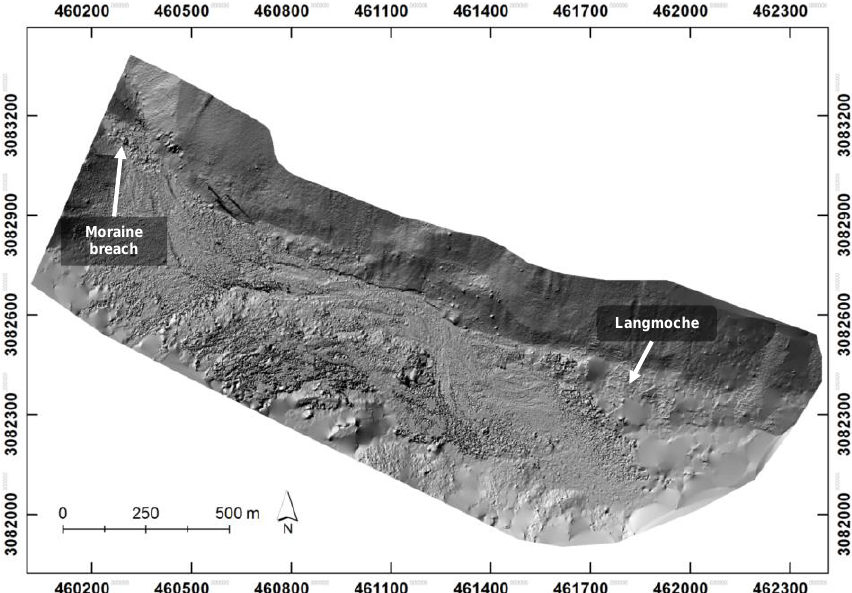
Figure 5. Hillshaded DTM of the Langmoche Valley floor (0–2.2km from breach), produced using terrestrial photography from the valley flanks in combination with structure-from-motion photogrammetric processing techniques. Elevation data were extracted at 1m 2 grid resolu- tion (from detrended mean cell elevation) from the geo-referenced data (UTM Zone 45N). DTMs of the breached moraine-dam complex are displayed in Westoby et al. (2012). Individual boulders up to ∼ 5m in diameter are resolved. Areas of weak reconstruction to the south-east of the domain are attributed to poor photographic density and topographic